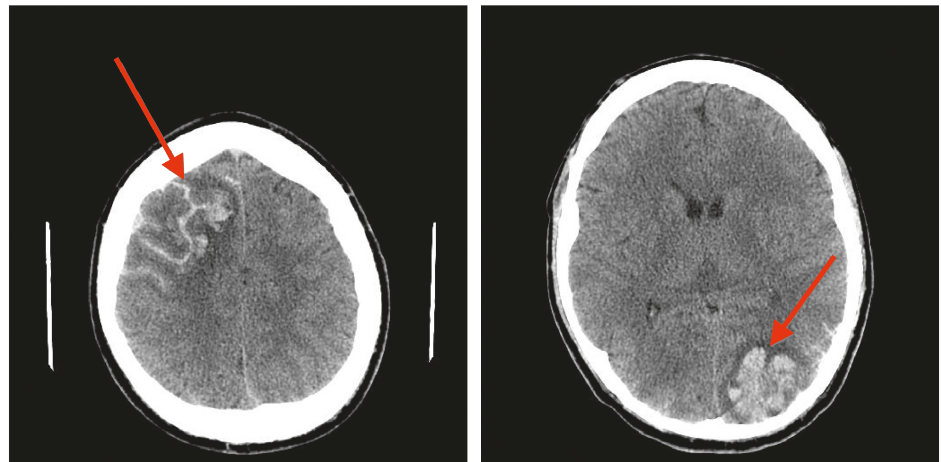
Figure 3: Head tomography showing cerebral infarction with secondary hemorrhagic